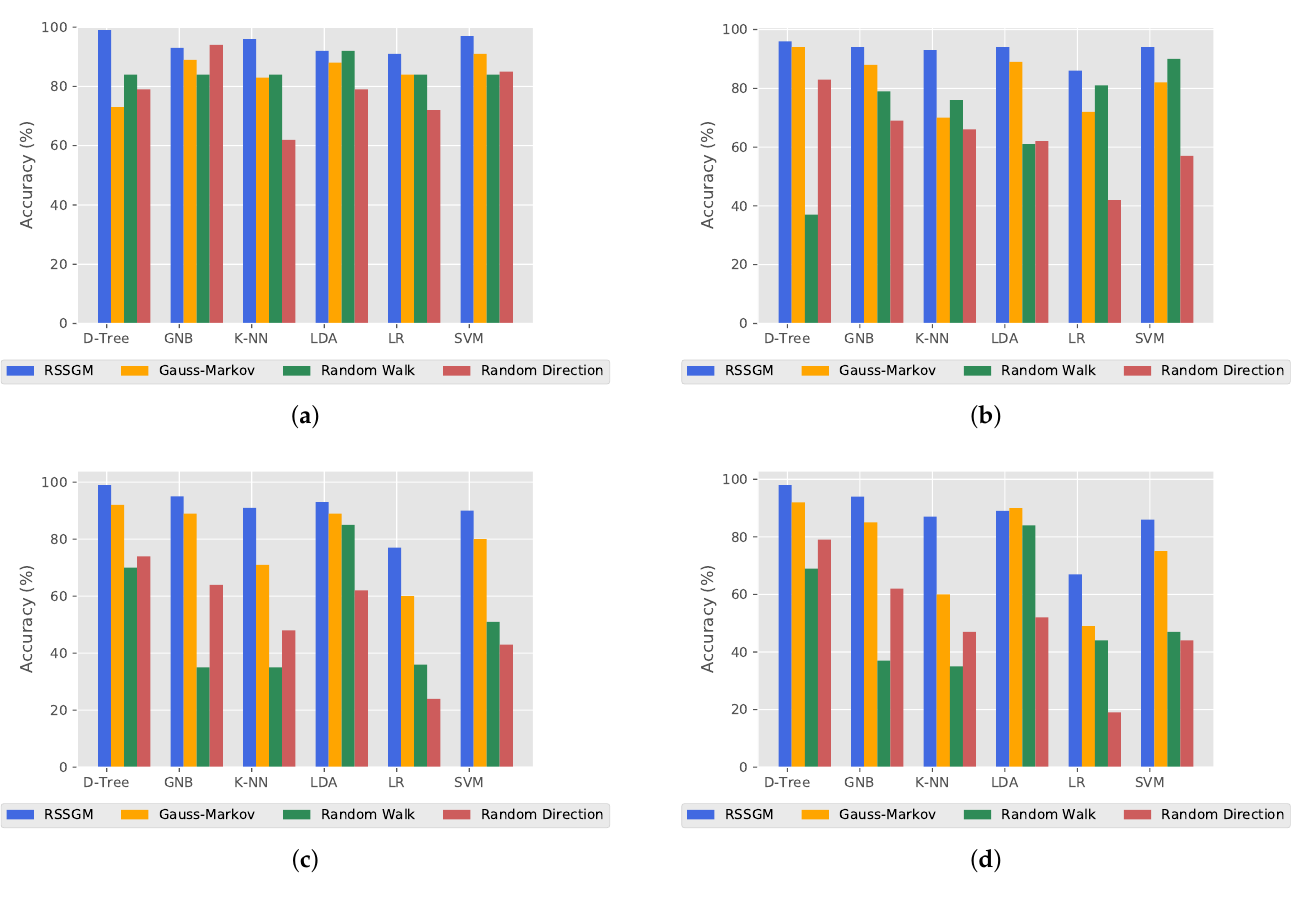
Figure 10. Example of different mobility model patterns using different number of APs and ten centroids. ( a ) Classifier accuracy with 5 APs. ( b ) Classifier accuracy with 10 APs. ( c ) Classifier accuracy with 15 APs. ( d ) Classifier accuracy with 20 APs.